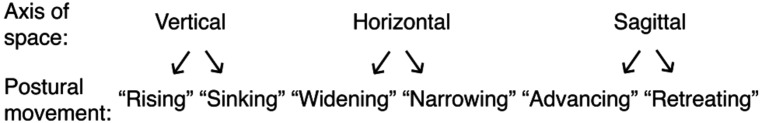
Postural shaping movement terms associate with the vertical, horizontal, and sagittal axes of space.